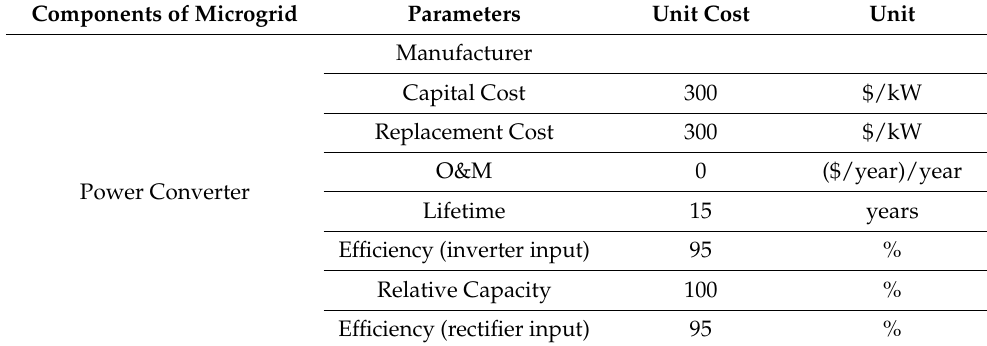
Table 2. Cont. Components of Microgrid